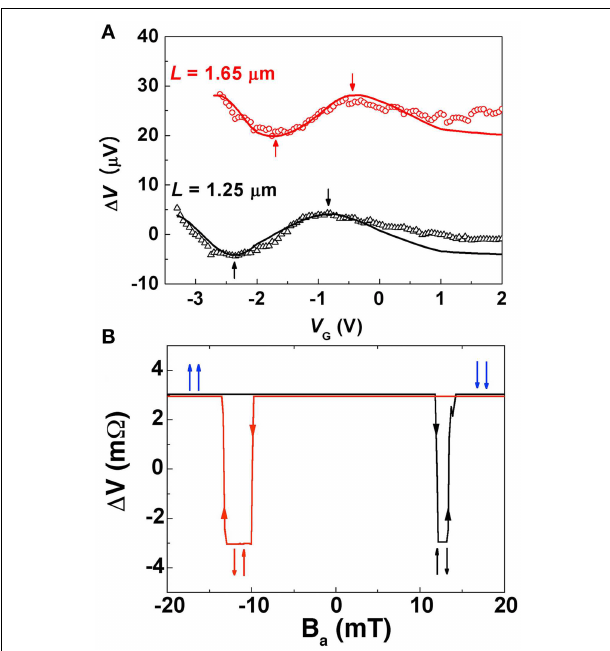
FIGURE 11 | (A) Datta Das conductance oscillation for two values of L . Symbols: data. Solid lines: fits. Details of the fits are found in Koo et al. [22] and Zainuddin et al. [33]. (B) NLSV magnetoresistance measurements using a small, variable in-plane field, B a , y . I 1 mA. The magnitude 1 R of the dips is = used as the amplitude A in the fits in (A) . Reproduced from Koo et al.